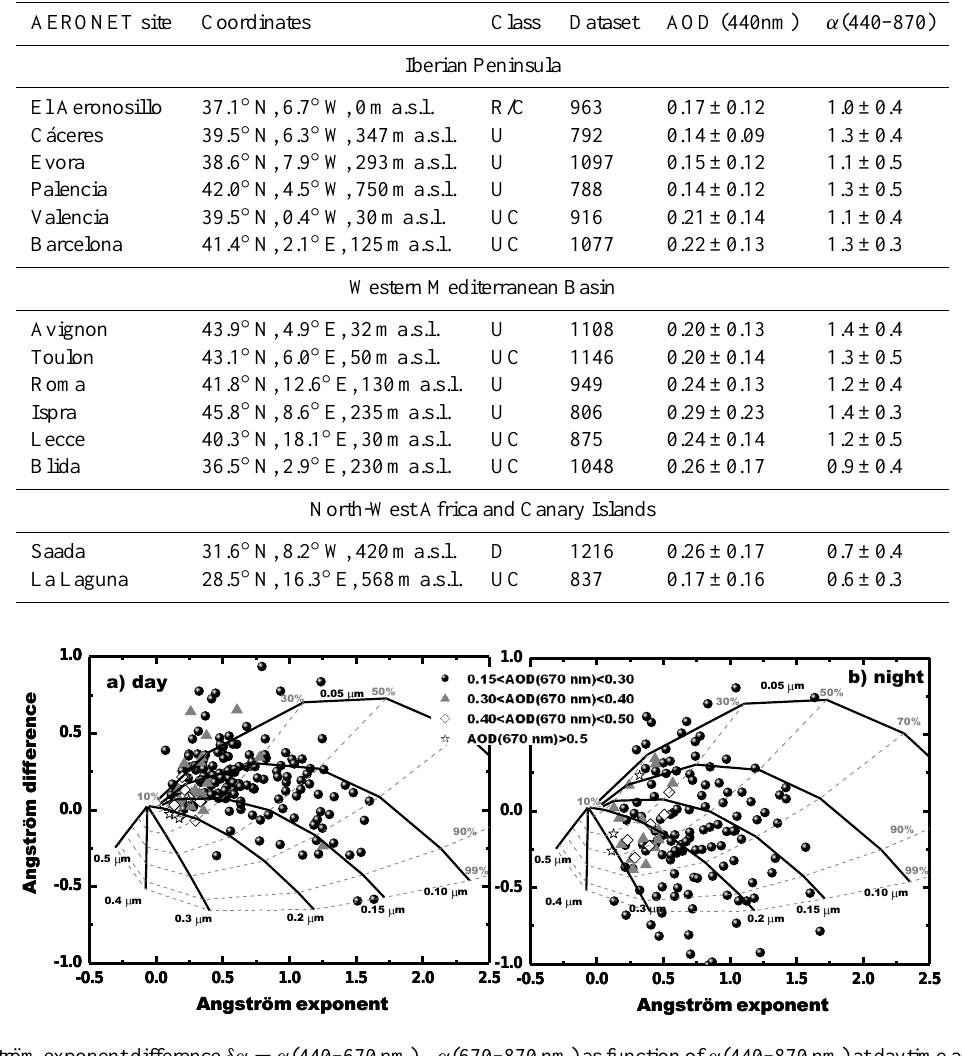
Fig. 4. (a) Angstr¨om exponent difference δα = α (440–670nm) − α (670–870nm) as function of α (440–870nm) at daytime and (b) Angstr¨om Figure 4: (a) Angström exponent difference δα = α(440-670 nm) - α(670-870 nm) as function exponent difference δα = α (436–670nm) − α (670–880nm) as function of α (436–880nm) at nighttime. Both δα and the Angstr¨om exponents of α(440-870 nm) at daytime and (b) Angström exponent difference δα = α(436-670 nm) - are the mean day or night values for the period 2007–2010. Different symbols indicate the ranges of aerosol optical depth at 670nm α(670-880 nm) as function of α(436-880 nm) at nighttime. Both δα and the Angström exponents are the mean day or night values for the period 2007-2010. Different symbols indicate the ranges of aerosol optical depth at 670 nm used.